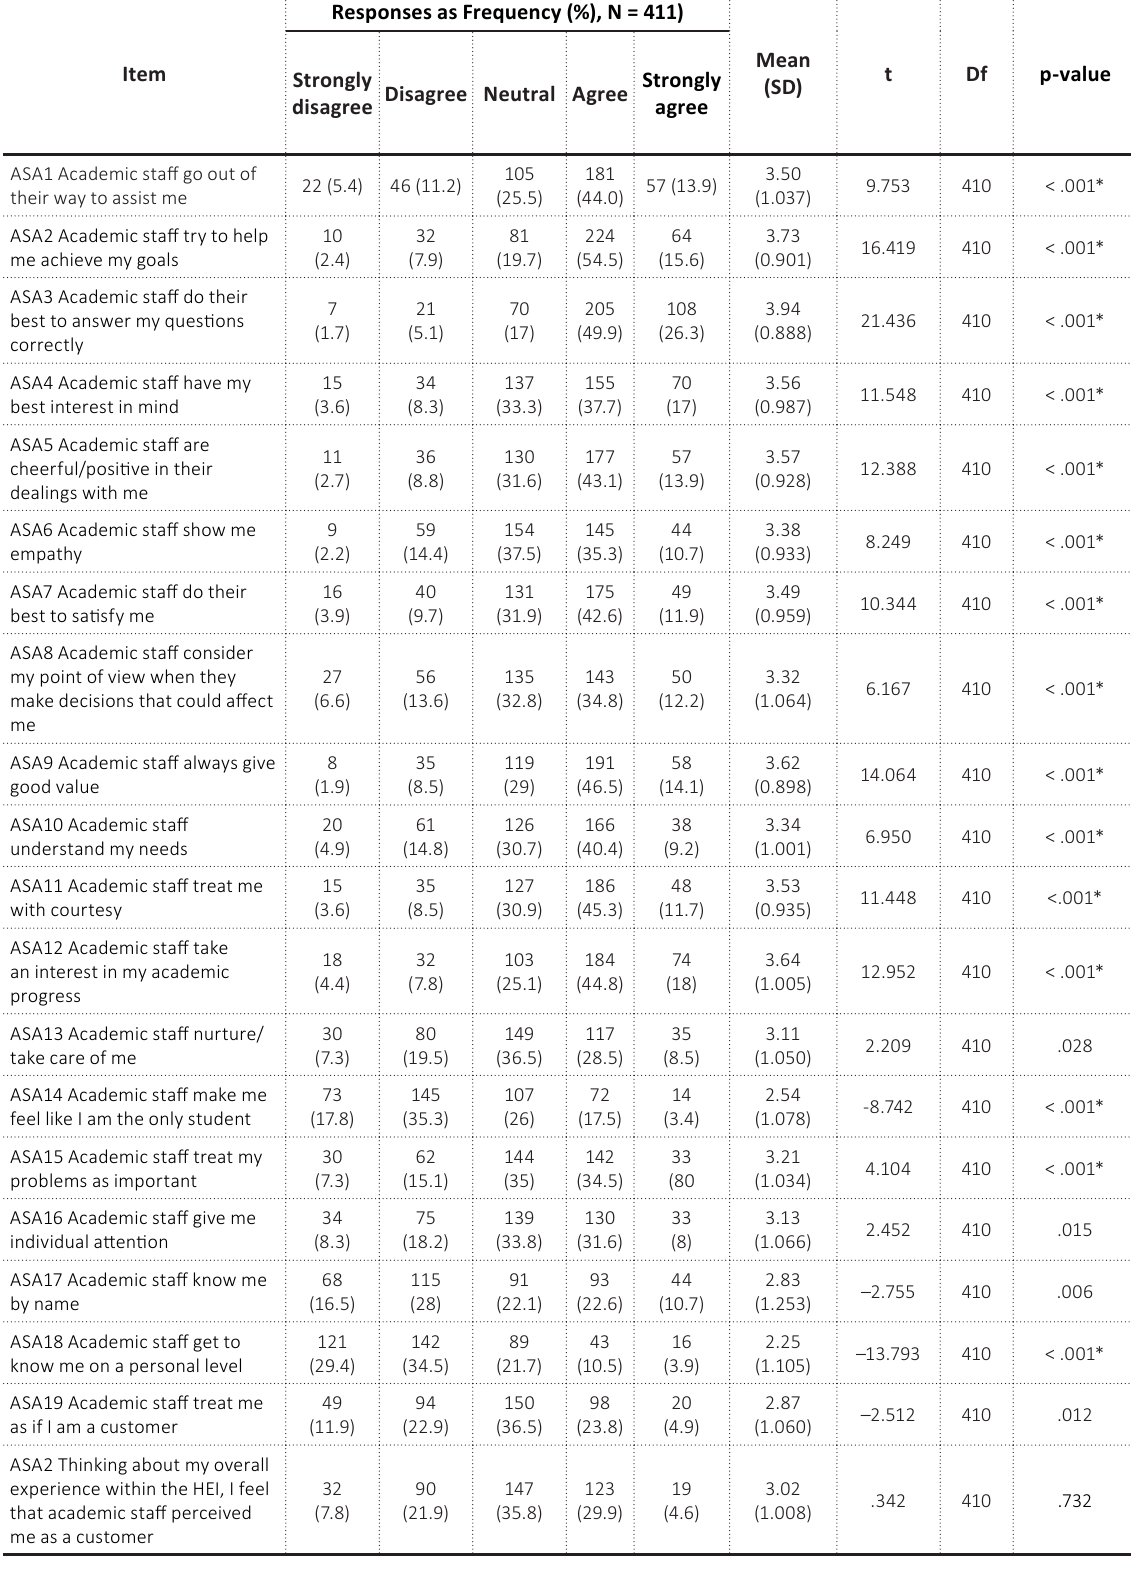
Table 2. Students’ perception of the attitude of academic staff Responses as Frequency (%), N = Item